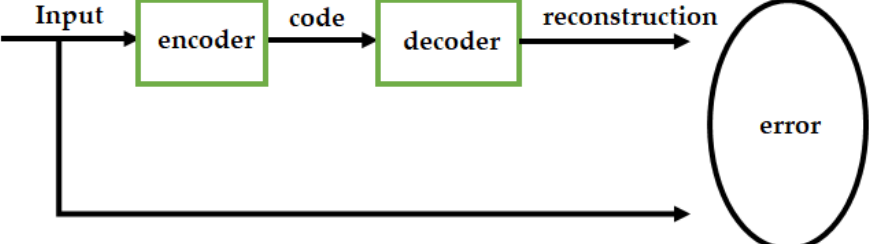
Figure 5. The pipeline of an autoencoder. Autoencoders are a special type of ANN used to learn efficient encodings, given an input x , instead of training the network to predict a target value y . Hinton et al. proposed the deep autoencoder, which has been extensively studied in [9]. Deep autoencoders are often trained with a variant of backpropagation such as the conjugate gradient